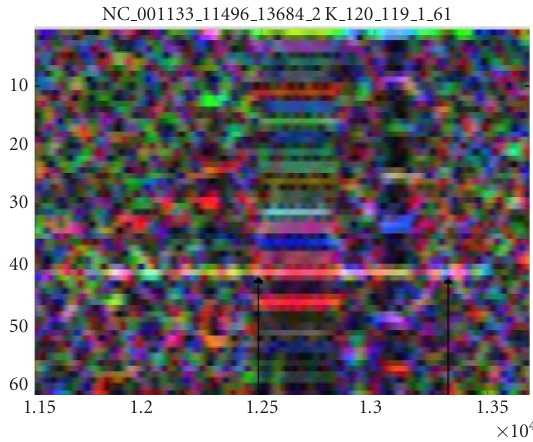
Figure 24: Spectrogram showing an unannotated pattern believed to correspond to a gene or pseudogene. The left arrow marks the end of a predicted gene. The right arrow marks the beginning of another predicted